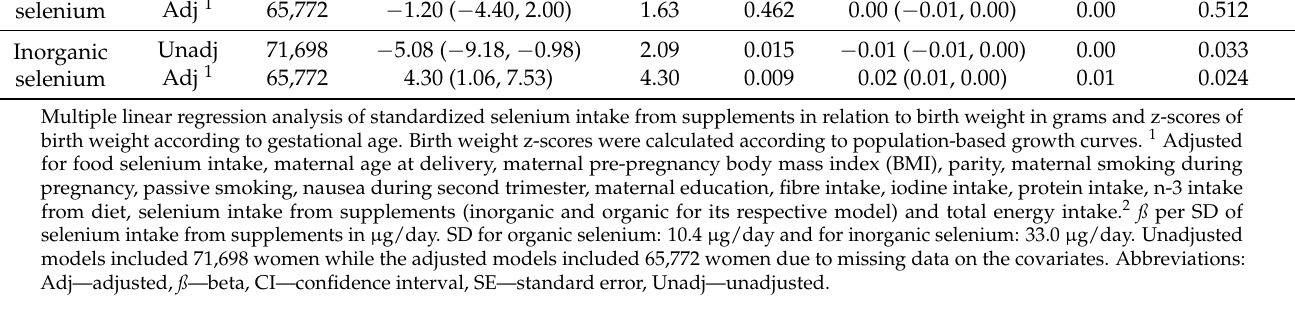
Table 5. Associations between maternal selenium intake from supplements and small for gestational age status in 71,728 women from the Norwegian Mother, Father and Child Cohort study.